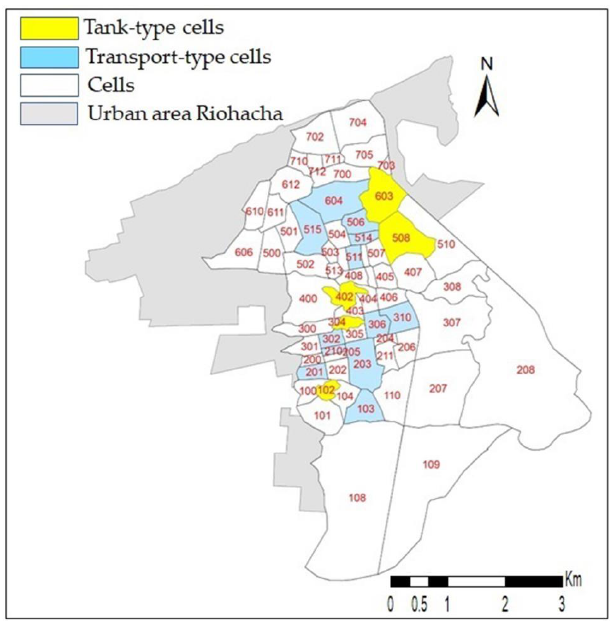
Figure 4 Figure 4. Cells considered for estimating the fitting quality of the